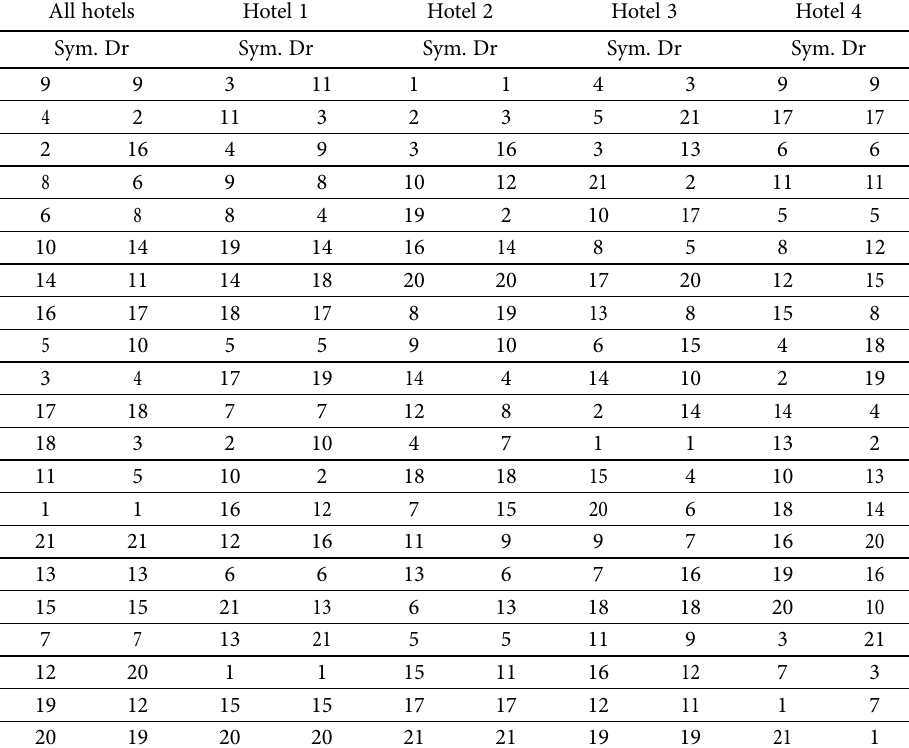
Table 10. Decreasing ordering of the importance of attributes All